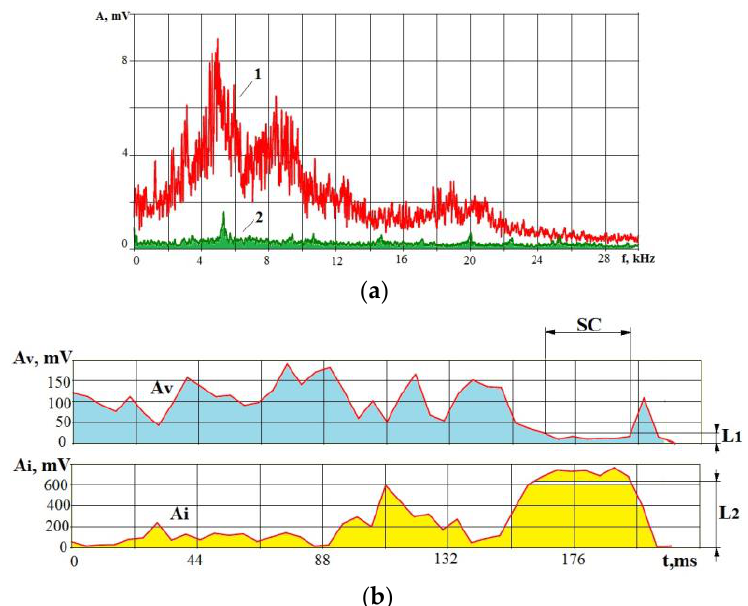
Figure 21. Changes in VA signal and current during short circuit: ( a ) VA signal spectrum during machining ( 1 ) and short circuit ( 2 ); ( b ) changes in time RMS of the signal amplitude VA (Av) and current (Ai) during short circuit.